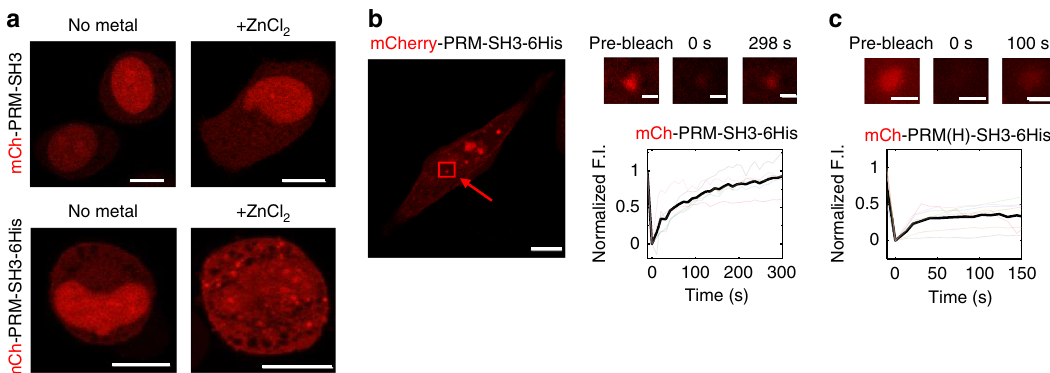
Fig. 6 Metal ion-induced phase separation in cells. a Fluorescence images of HeLa cells expressing mCherry-fused PRM-SH3 (top) and PRM-SH3-6His (bottom) scaffold proteins with or without 1 μ M Zn 2 + treatment for 60 min. Scale bars: 10 μ m. b FRAP recovery pro fi les and images of cellular mCh-PRM- SH3-6His condensates (scale bars: 1 μ m). The whole cell image that contains the bleached condensate is shown on the left (scale bar: 10 μ m). c FRAP recovery pro fi les and images of cellular mCh-PRM(H)-SH3-6His condensates. Scale bars: 1 μ